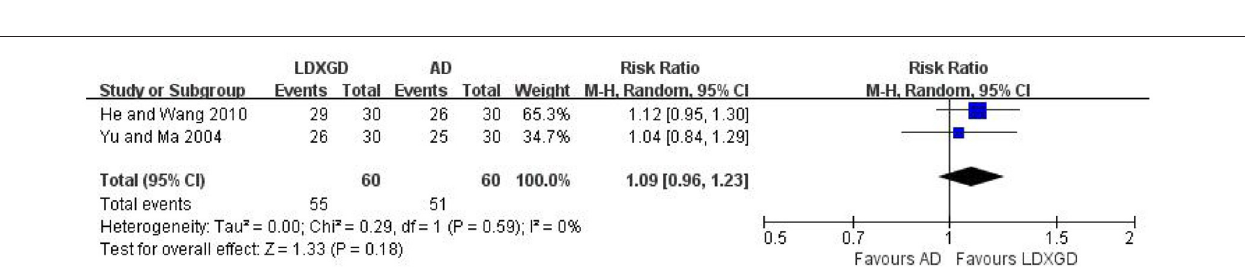
FIGURE 2 | Forest plots of the comparison of LPAD vs. antihypertensive drugs for the outcomes of BP: (A) SBP, (B) DBP, and (C) BP. AD, antihypertensive drugs; BP, blood pressure; DBP, diastolic blood pressure; LPAD, longdanxiegan decoction plus antihypertensive drugs; SBP, systolic blood pressure.